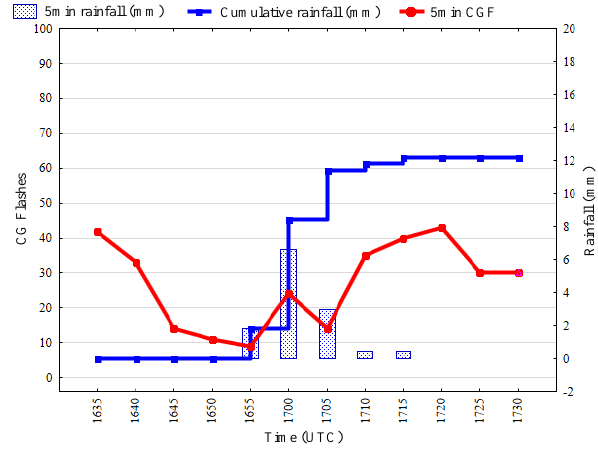
Figure 13. Critical interval time series for debris flow event of 18 August 2011. This is an event from the STH group and debris flow initiation was observed at